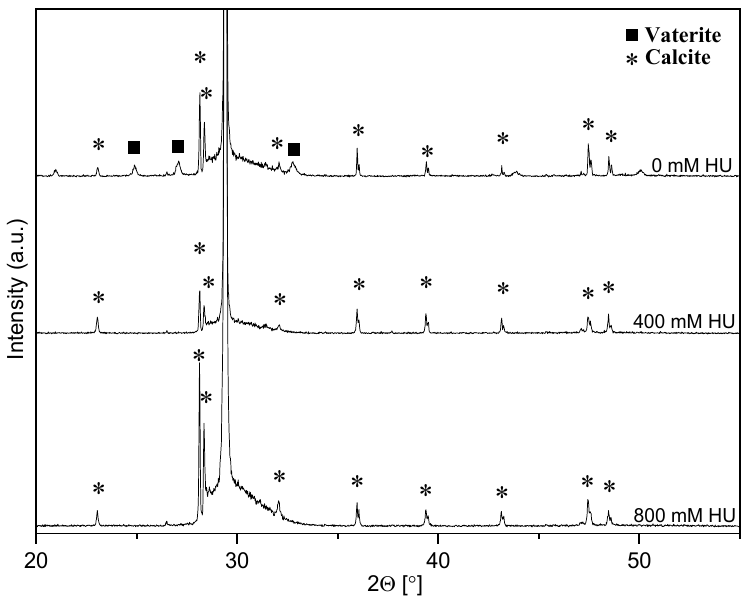
Figure 2. Diffraction patterns for calcite with and without drug. Both vaterite ( ▪ ) and calcite (*) were formed with no drug present while only calcite was formed in the presence of hydroxyurea.